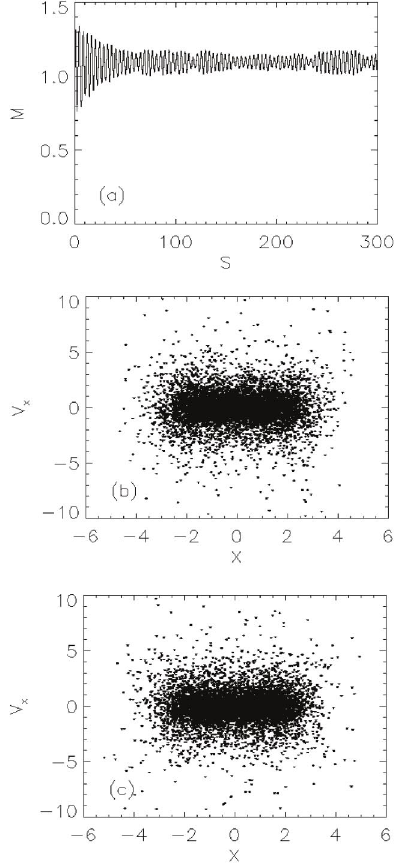
FIG. 1. Linear oscillations. (a) Oscillation of the rms width of the core with (cid:4) (cid:1) 1 : 35 , (b) test particle distribution at last minimum rms width when S (cid:10) 300 , (c) test distribution at last maximum rms width when S (cid:10) 300 .